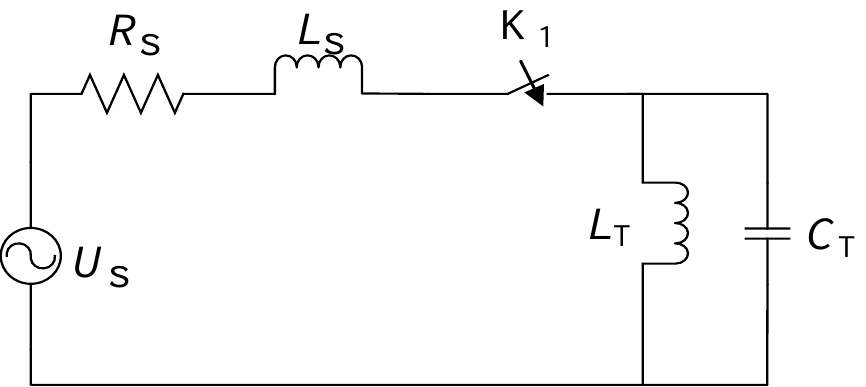
Figure 1. Equivalent circuit of vehicle-mounted circuit breaker closing.